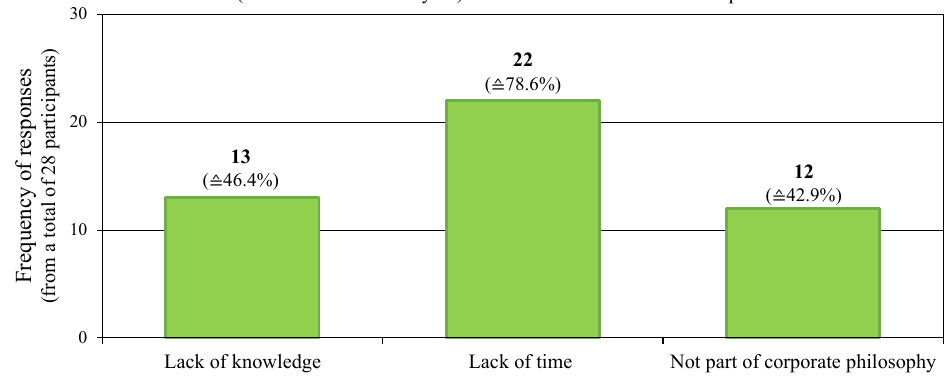
Figure 6. Response of 28 participants to the (multiple-choice) question: “Why does your company not make any efforts (such as tolerance analyses) to take account of deviations in products?” (multiple answers were allowed).